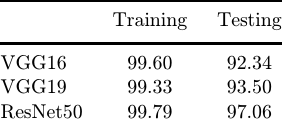
Table 3. Accuracies of VGG16, VGG19 and ResNet50.